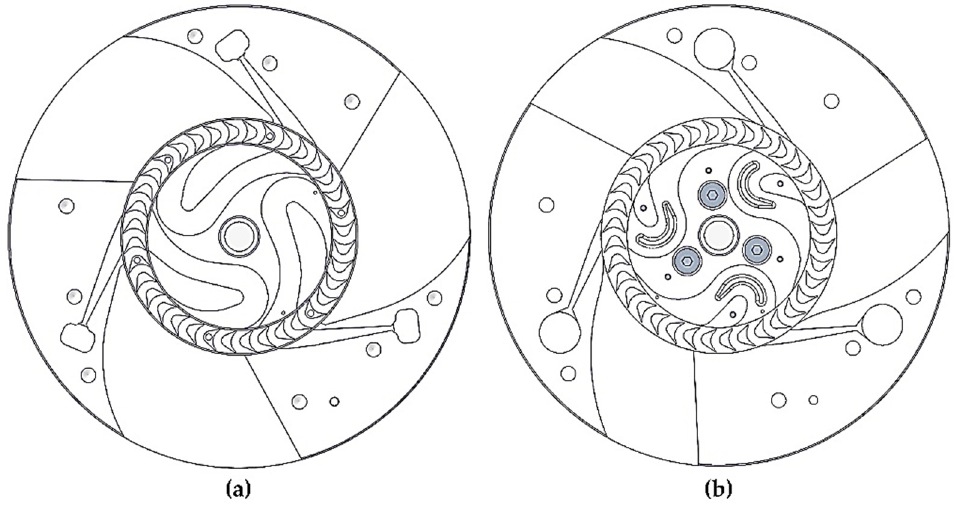
Figure 12. Elektra flow geometry design: ( a ) Version 1 , 2a and 2b ; ( b ) Version 3 .